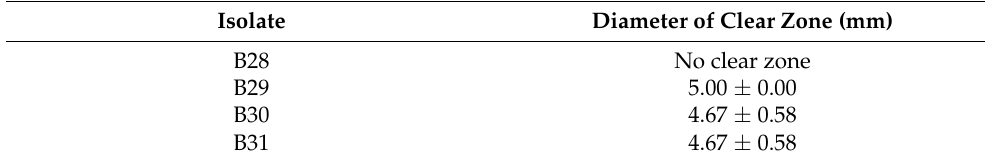
Table 3. Protease-producing capacity of the probiotic candidates.